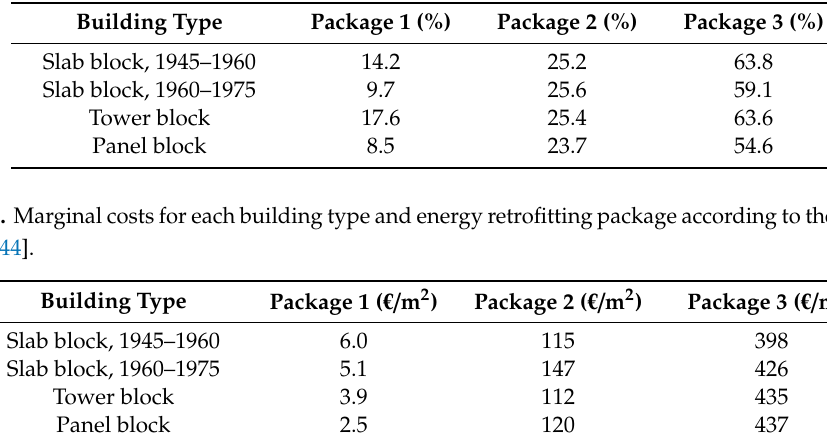
Table 2. Percental energy savings for each building type and energy retrofitting package according to the reference study [44].